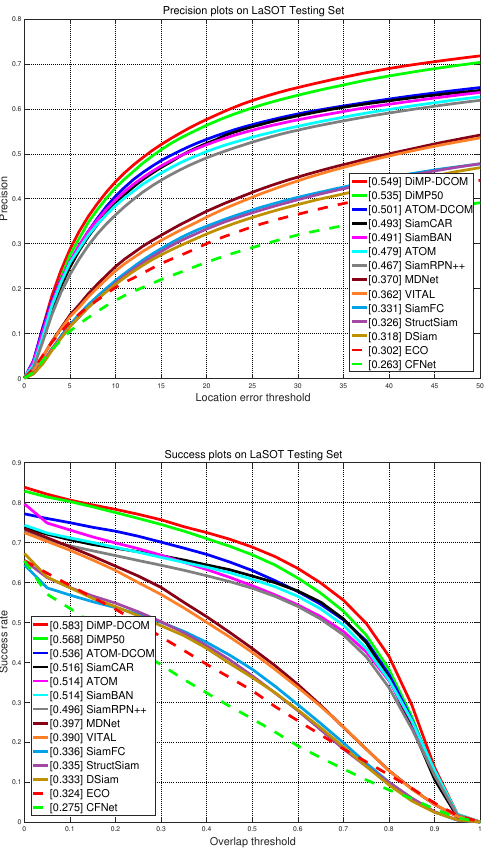
Figure 3. Comparisons with state-of-the-art trackers on LaSOT [22] in terms of precision plots and success plots. All the figures are drawn by the official toolkit. Table 4. Comparisons with the state-of-the-art trackers on LaSOT.